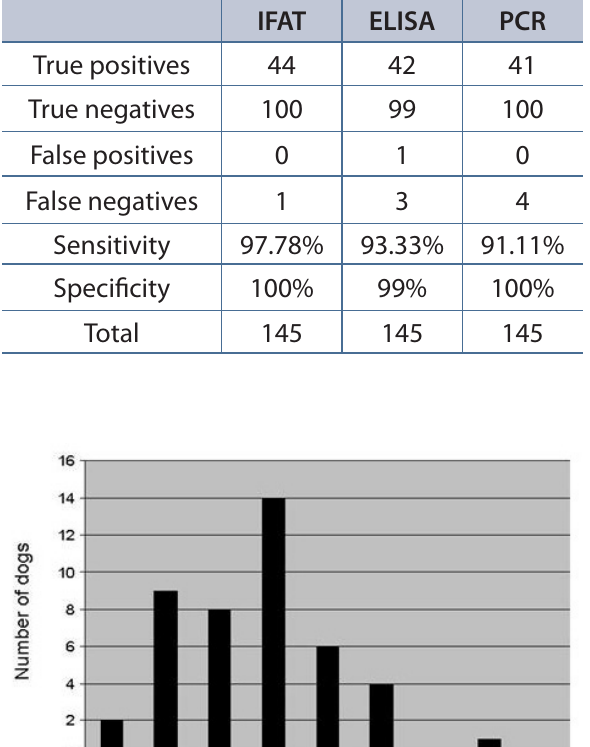
Table 2. Results of IFAT, ELISA and PCR, compared with direct parasitological test (gold standard) IFAT